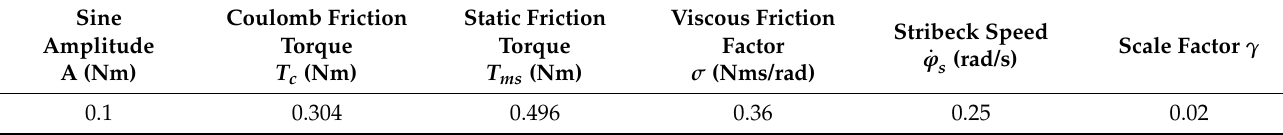
Table 3. Initial parameter setting of current model.